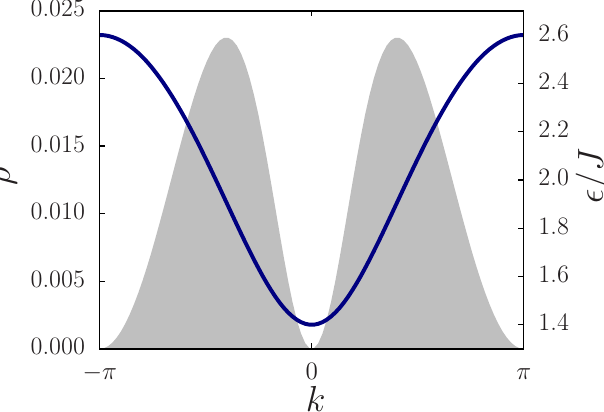
Figure 2.1: The kink dispersion relation ε ( k ) for g = 0.3 (full line) and the initial density ρ ( k ) (shaded region) for g